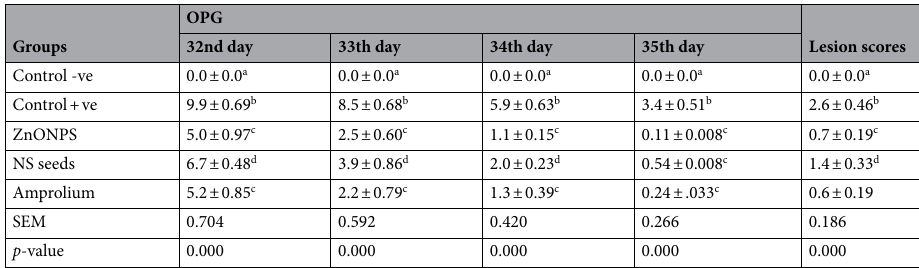
Table 2. Oocyst per gram (× 10 4 ) and caecum lesion scores of the broiler birds challenged with Eimeria tenella and treated with different treatments at 28–35 days of age. (Mean ± S.D). Values are Mean ± S.D. Control –ve = Un-infected and un-treated, Control + ve = Infected and un-treated, ZnONPs = Infected and treated with 60 mg/kg ZnONPs orally, NS seeds = Infected and treated with 1% Nigella sativa crushed seeds, Amprolium = Infected and treated with amprolium; SEM: standard error of mean. a,b, c,d mean within a column with different superscripts are significantly different at (p <